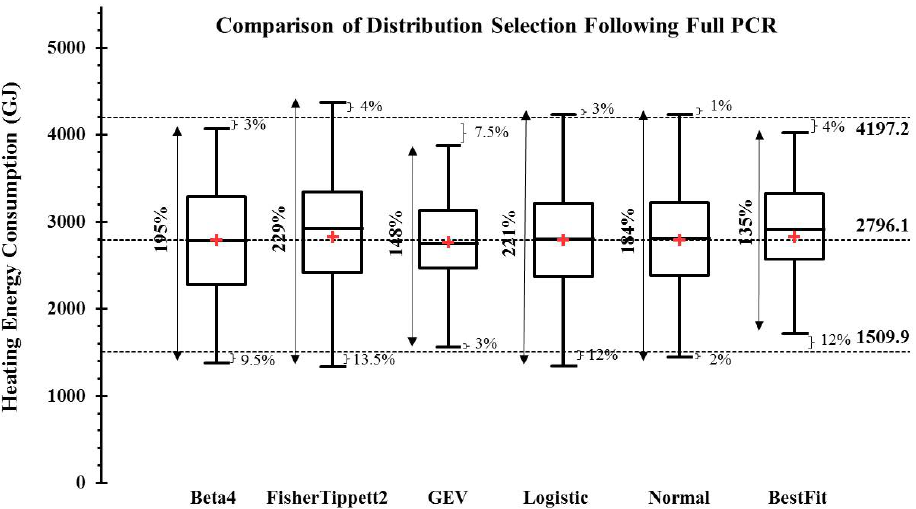
Figure 8. Heating energy use probability density functions when following a Full Principal Component Regression model and comparing selection of various input principal component distribution series used in the uncertainty propagation method.